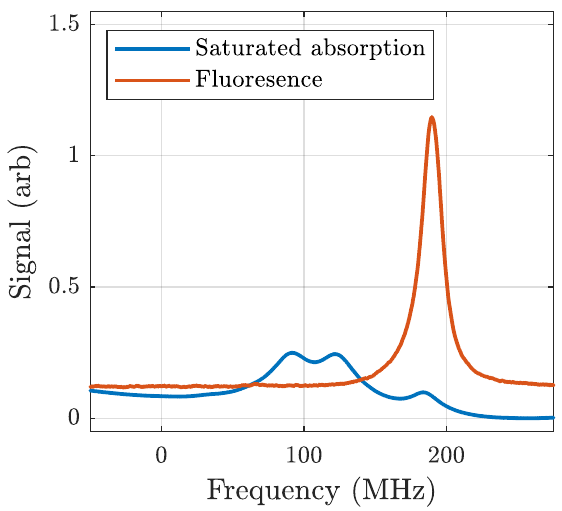
Figure 2. Frequency difference between fluorescence from atoms in the atomic beam and a simultane- ous saturated absorption spectrum. The difference suggested a most probable atomic beam velocity of ∼ 4.4